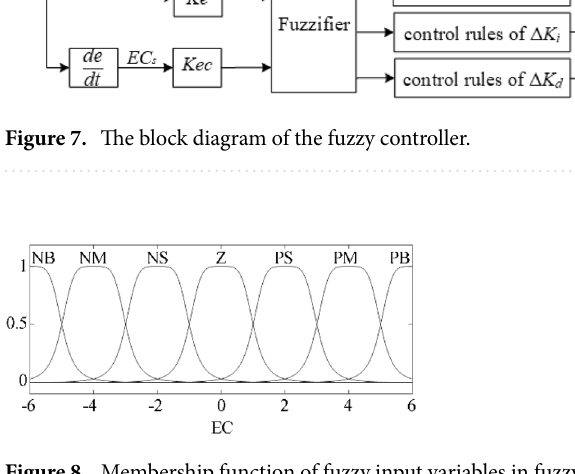
Figure 8. Membership function of fuzzy input variables in fuzzy PID